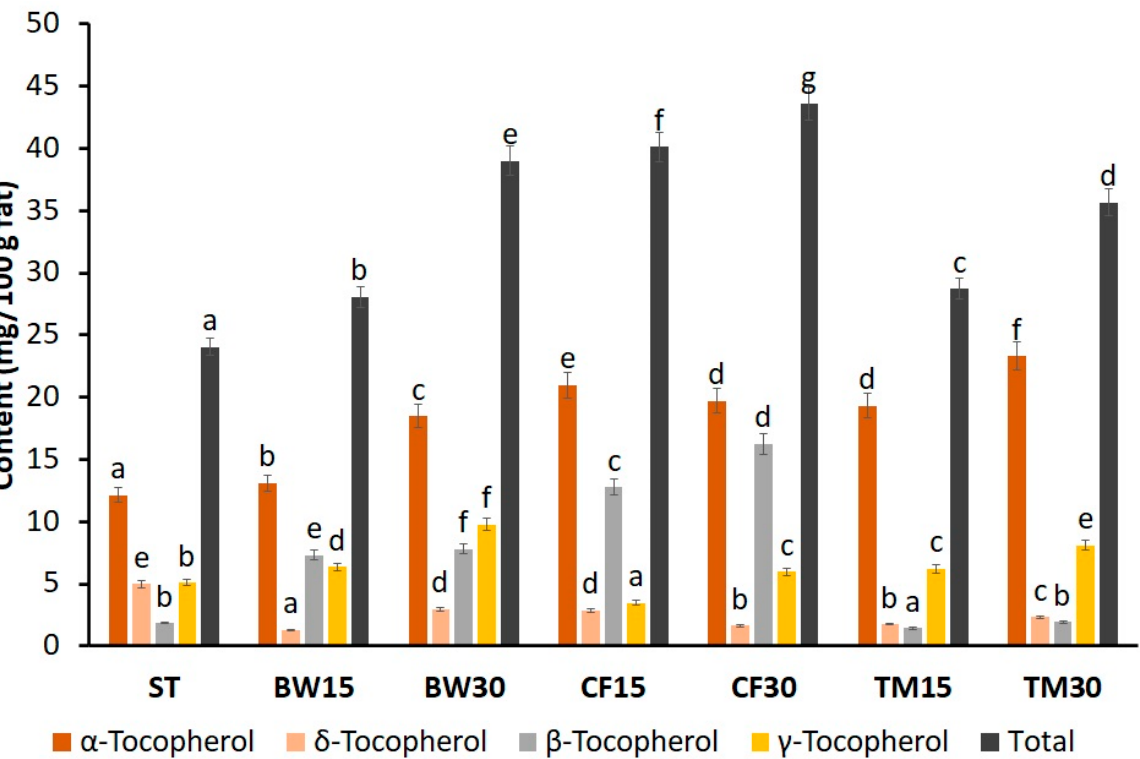
Figure 1. Composition of tocopherols in the standard and edible insect flour-substituted bars (Values marked with the same letter do not differ statistically significantly at p < 0.05).